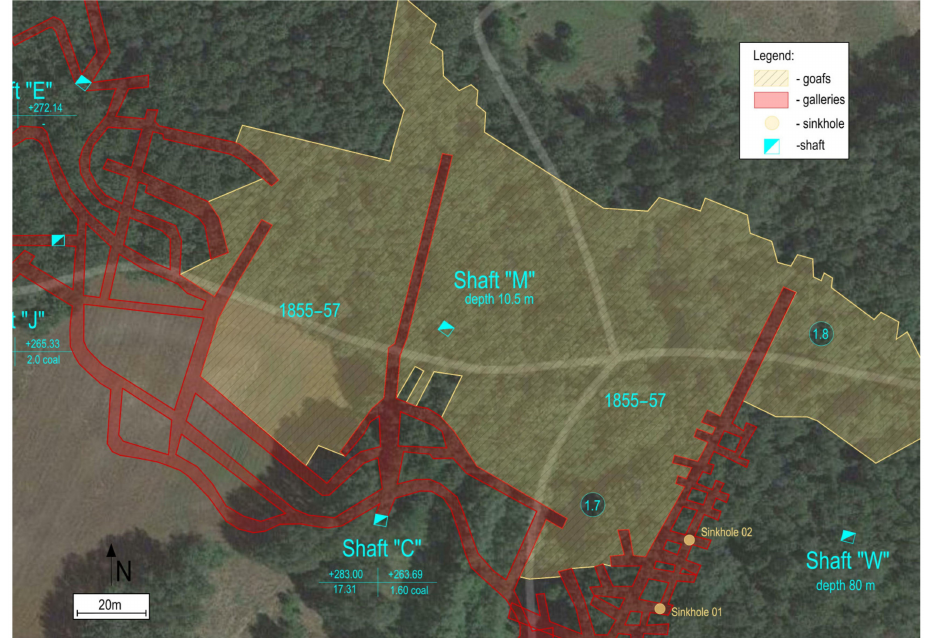
Figure 9. Location of the research area against the underground